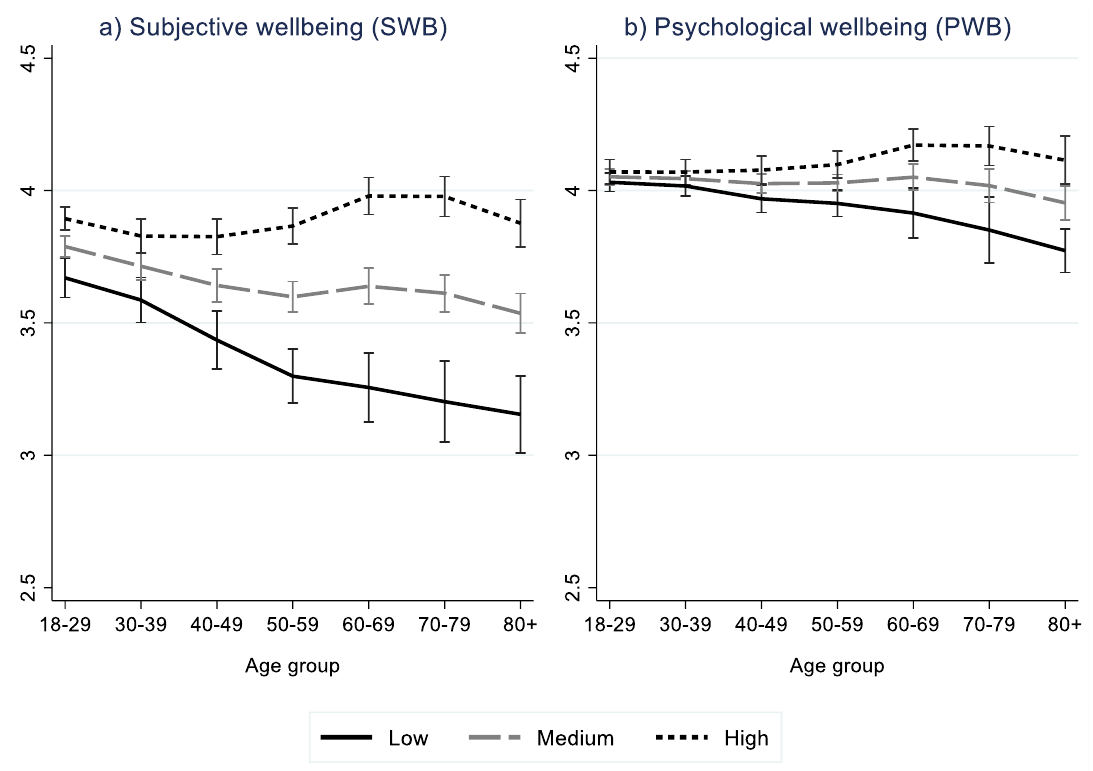
Figure 3. Predicted level of subjective wellbeing ( a ) and psychological wellbeing ( b ) by age and high (p90), medium (p50) and low (p10) value of WS index. Results from multilevel regression (Model 1). NB Scale in Figure 2.5 – 4.5.